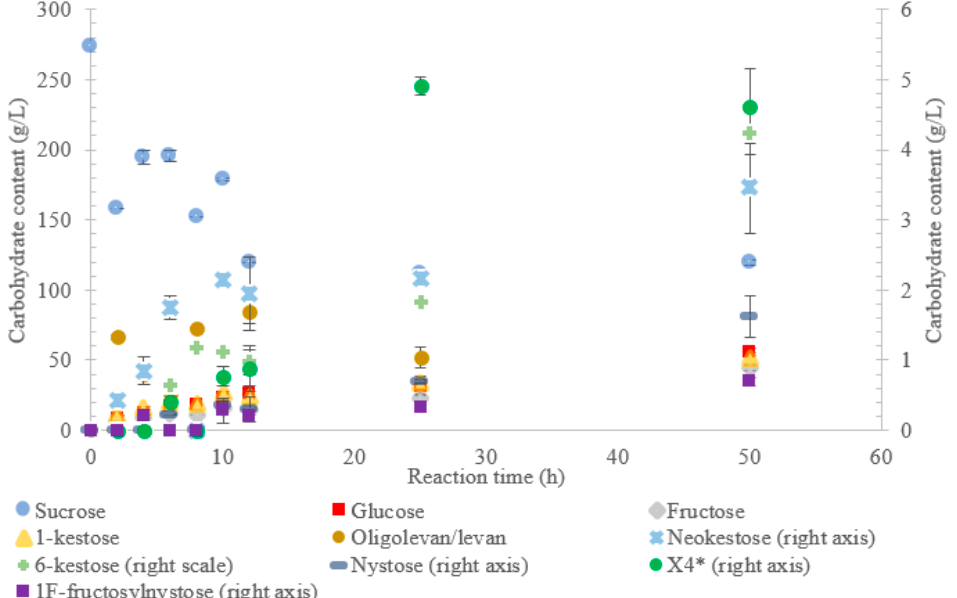
Figure 1. Reaction product profile of LS from Vibrio natriegens with sucrose for 50 h at 30 °C. *X4 is a tetrasaccharide peak separate from nystose.